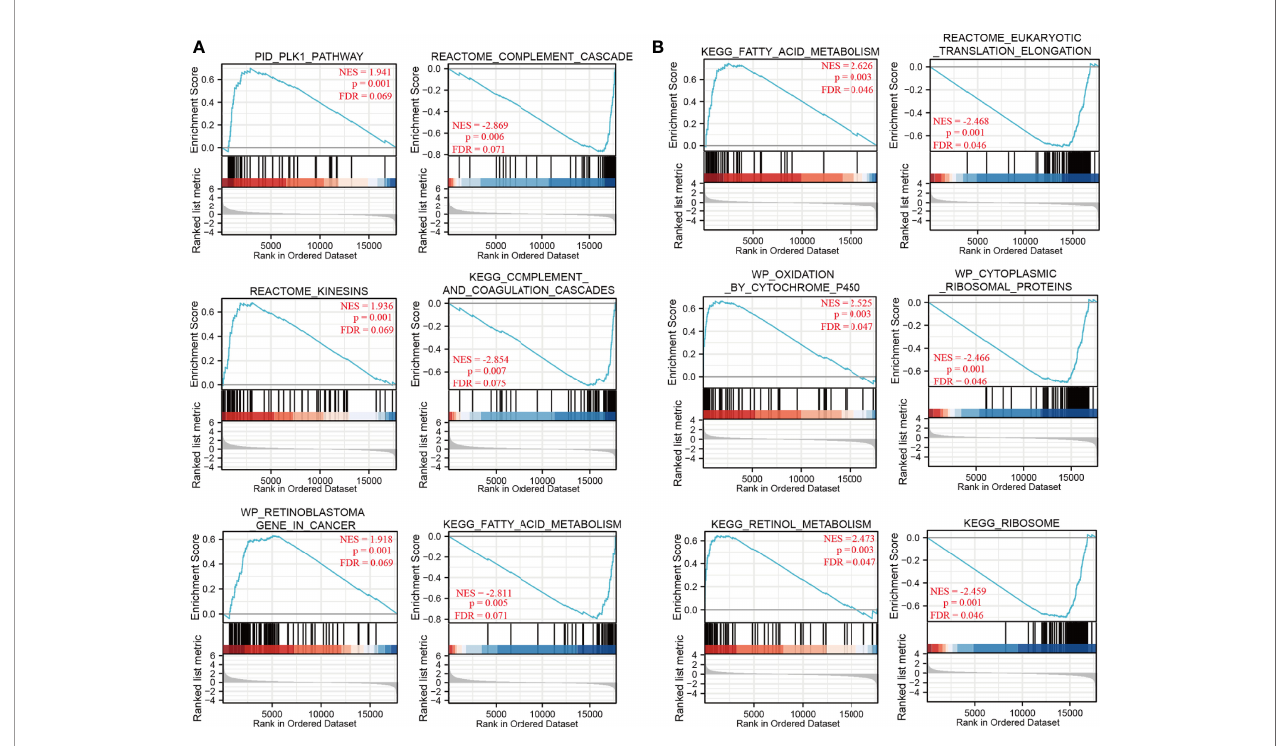
FIGURE 4 | The gene set enrichment analysis of NDRG1 and NDRG2. (A, B) Representative enrichment plots from GSEA. Several pathways and biological processes were differentially enriched in NDRG1 and NDRG2 -related hepatocellular carcinoma. NES, normalized enrichment score; p.adj, adjusted P-value; FDR, false discovery